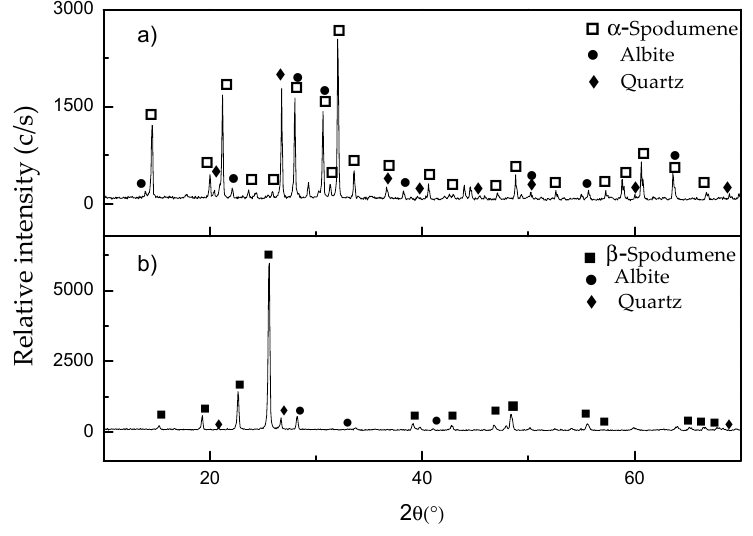
Figure 1. Diffractograms of the mineral: ( a ) α -spodumene and ( b ) β -spodumene.